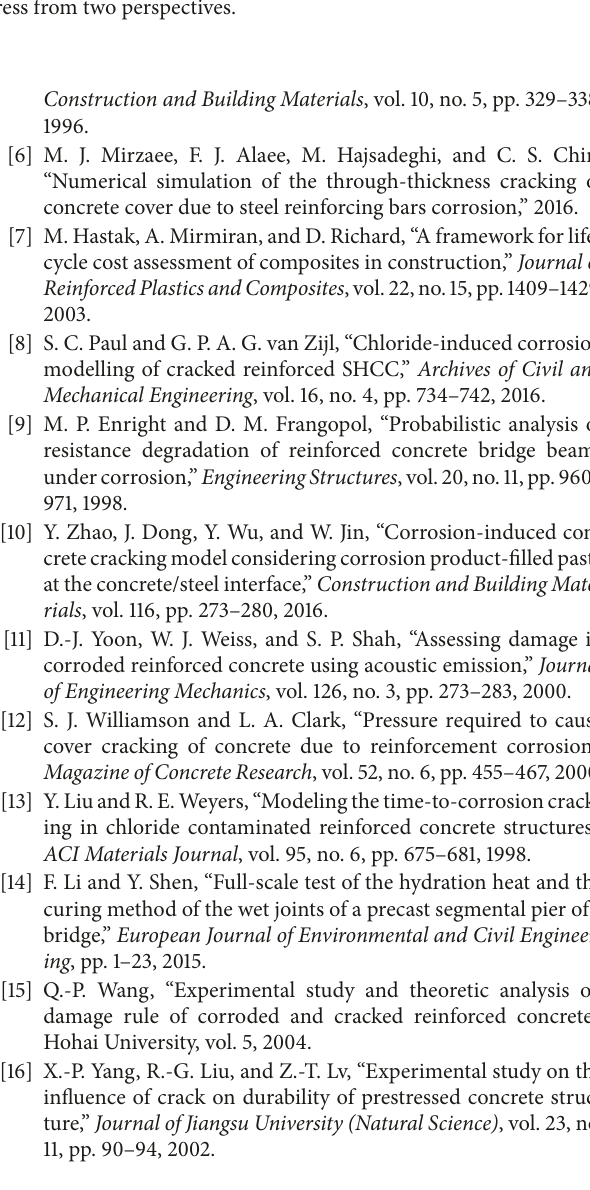
Figure 42: Principal tensile stress from two